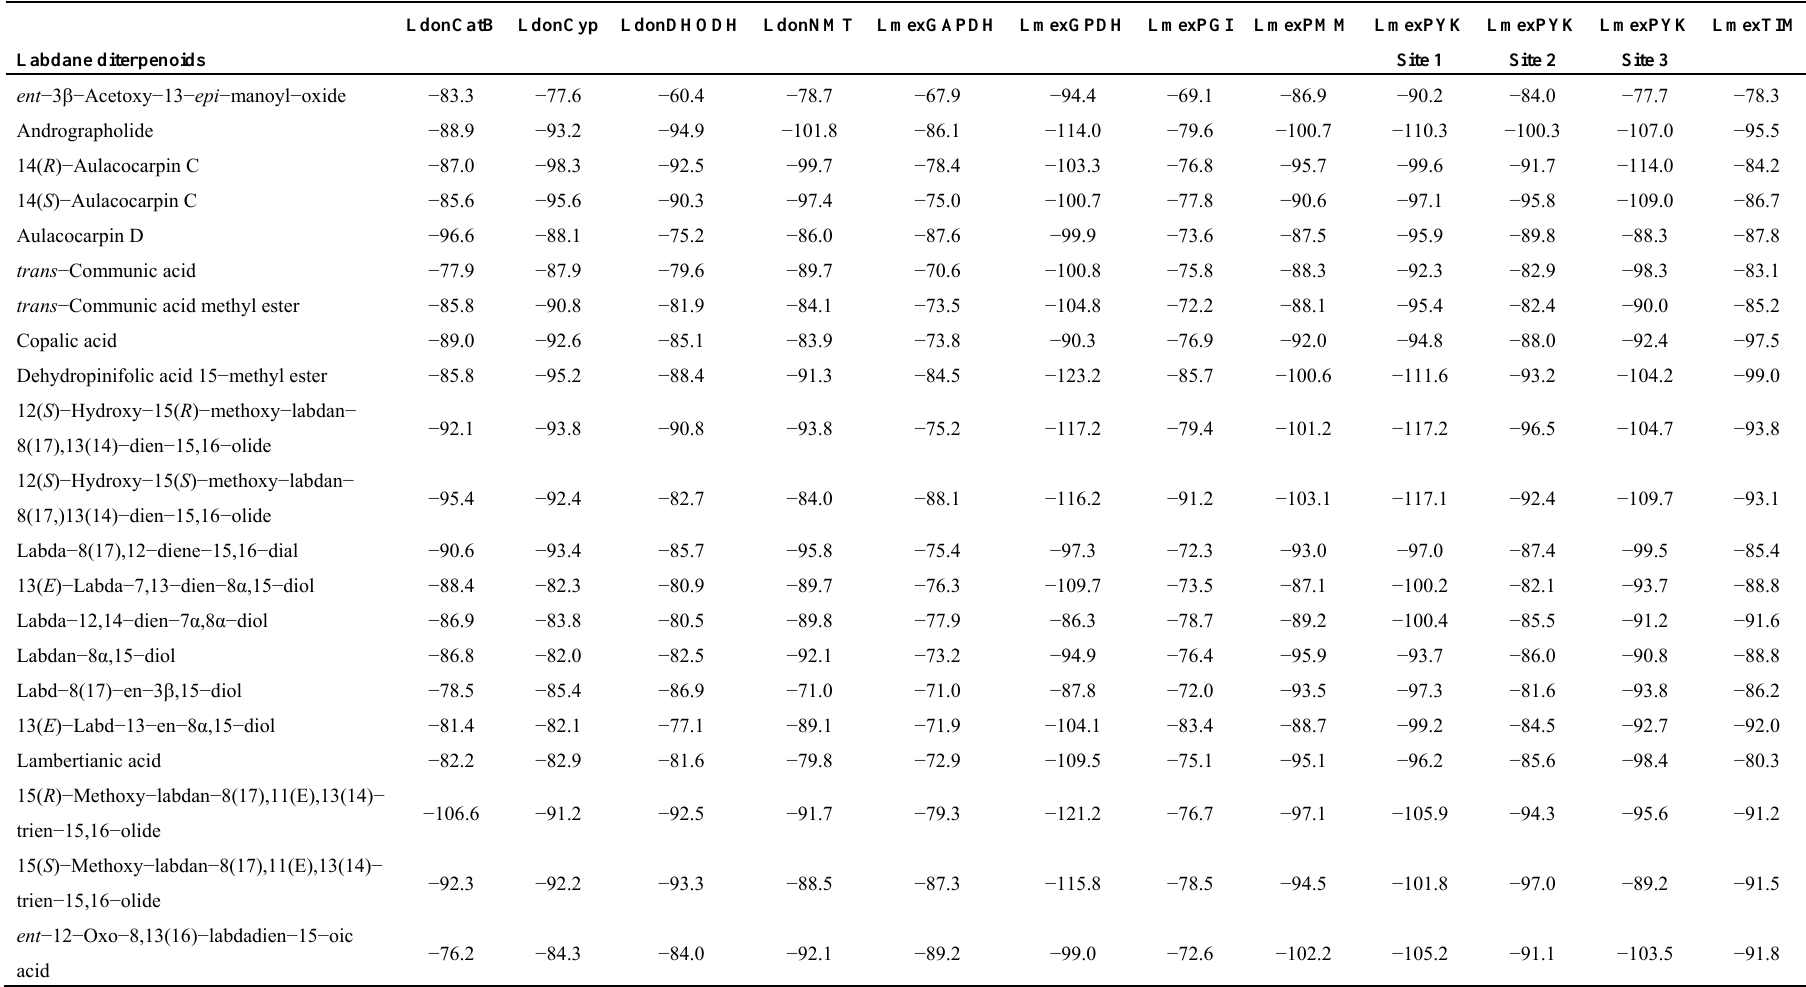
Table 23. MolDock docking energies (kJ/mol) of labdane diterpenoids with Leishmania donovani and L. mexicana protein